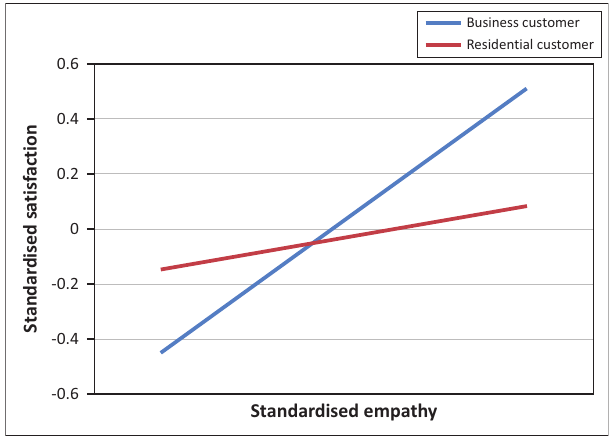
FIGURE 2. Simple slopes for standardised empathy on standardised satisfaction at business and residential customer